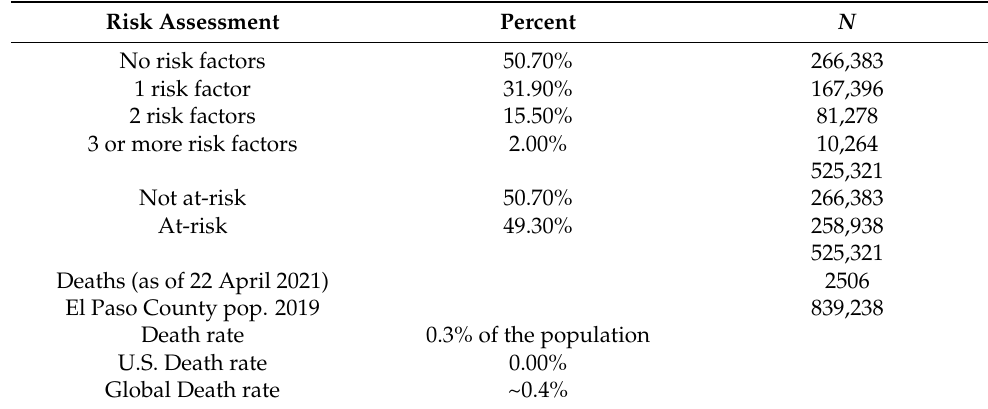
Table 6. Number of Pre-Existing Health Conditions Associated with Severe Illness Related to COVID-19 among Hispanics in El Paso in